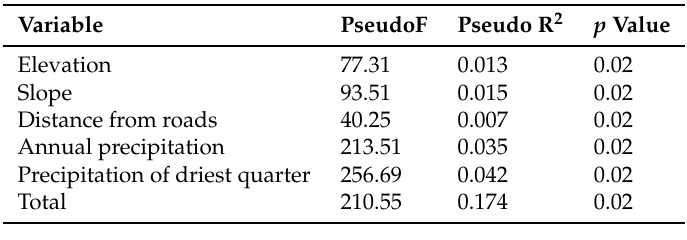
Table 3. Multi-factor ANOVA results.